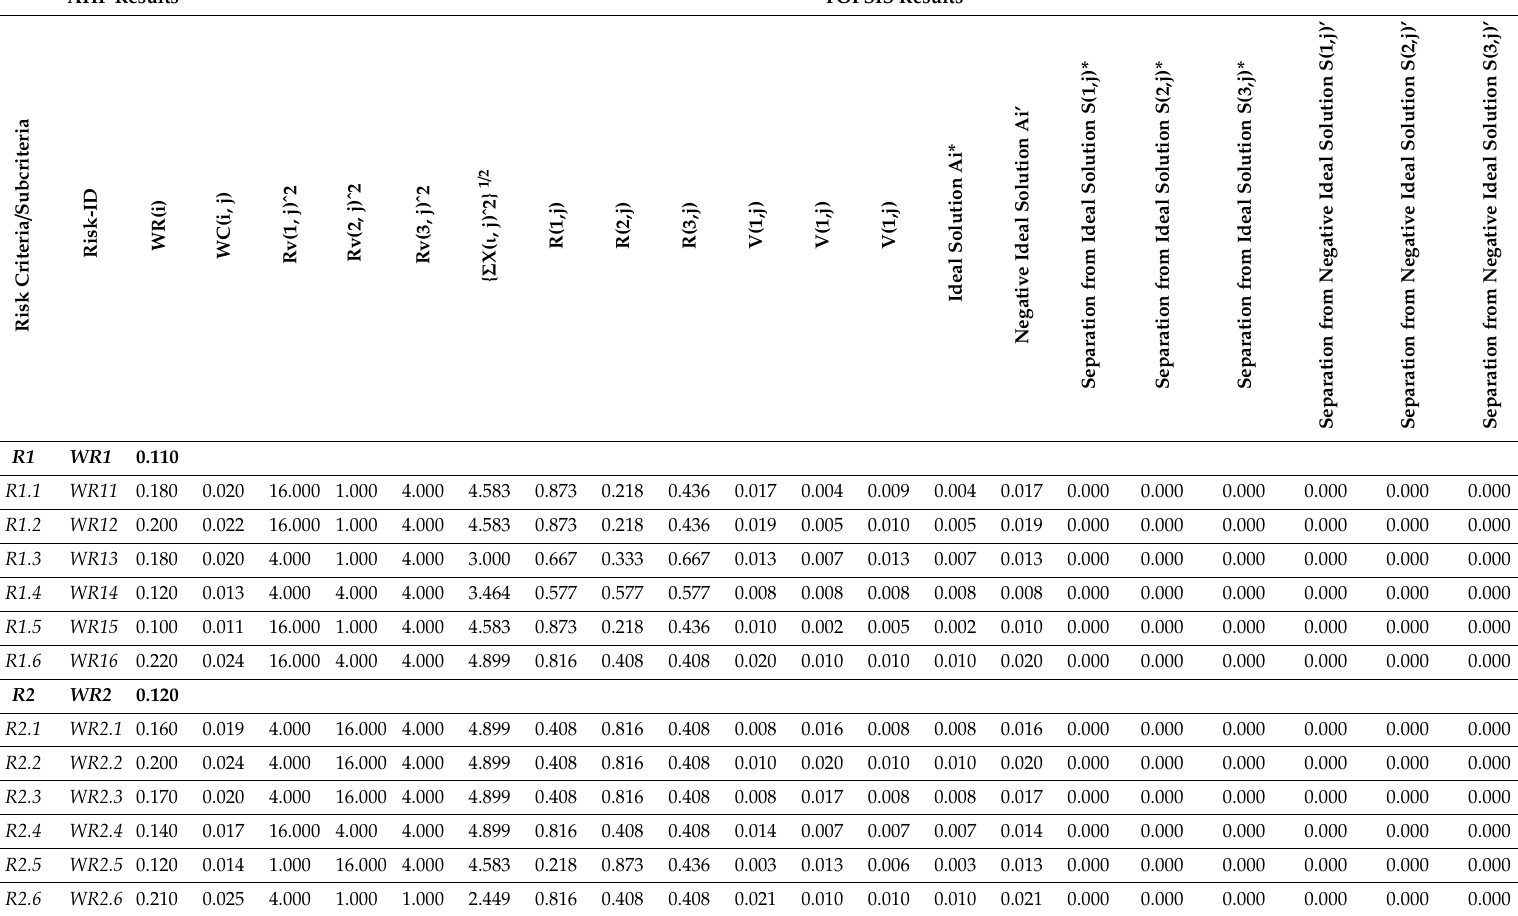
Table 11. Results of the Combined AHP and TOPSIS (technique for order of preference by similarity to ideal solution) Methodology—Final Ranking of Alternatives. AHP Results TOPSIS